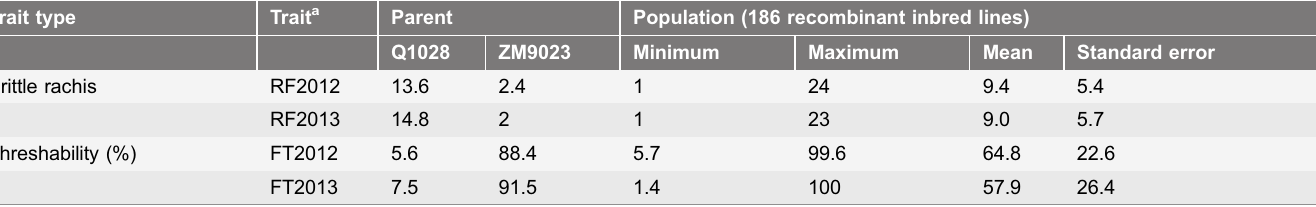
Table 1. Phenotypic values for brittle rachis and threshability in Triticum aestivum ssp. tibetanum Shao population from accessions Q1028 6 ZM9023. Trait type Trait a